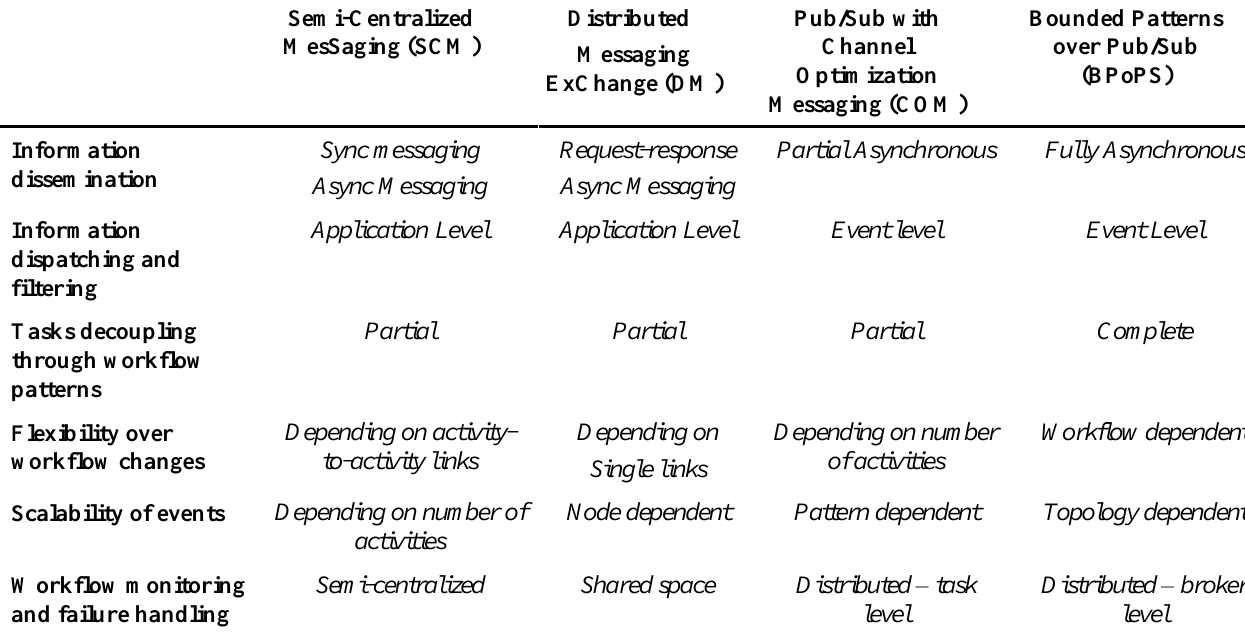
Table 1. SWf execution requirements and communication